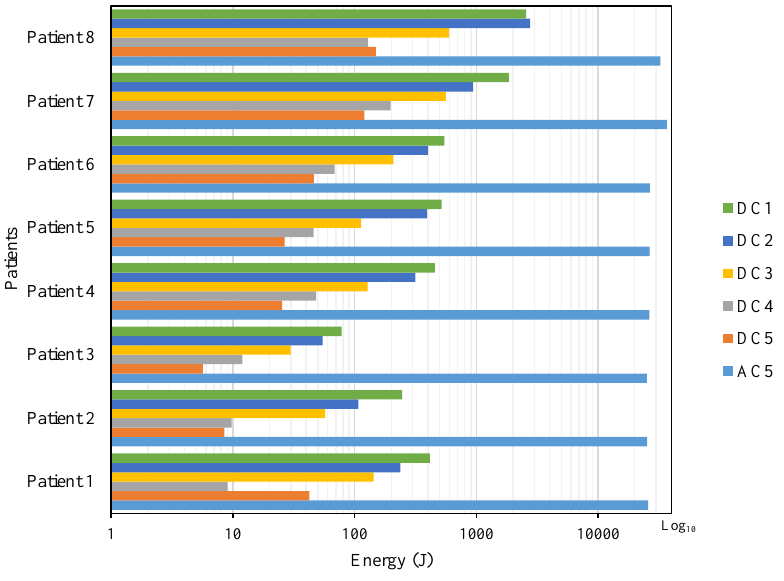
Figure 8. Distribution of total energy in the subbands of the wavelet